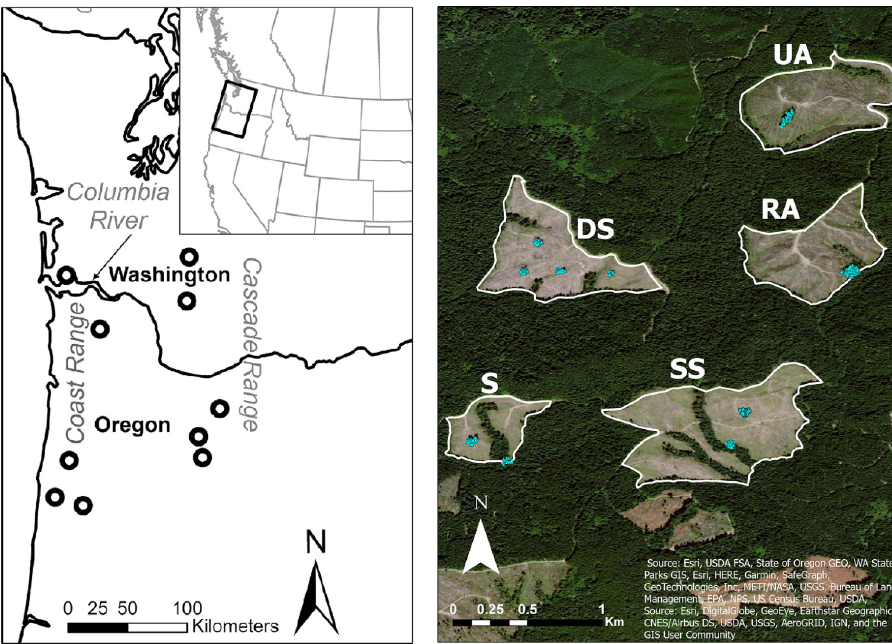
Fig 1. Location of ten experimental blocks with five structural retention treatments in each block (left panel) and aerial view of one experimental block showing each of the five experimental retention stands with the location of retained structures in each stand depicted by blue triangles (right panel), Oregon and Washington, U.S.A. Half of the retained structures in the SS and DS treatments consisted of created snags, shown in Fig 2. RA = Riparian Aggregated, UA = Upland Aggregated. S = Split; SS = Split with Snags; and DS = Dispersed with Snags.